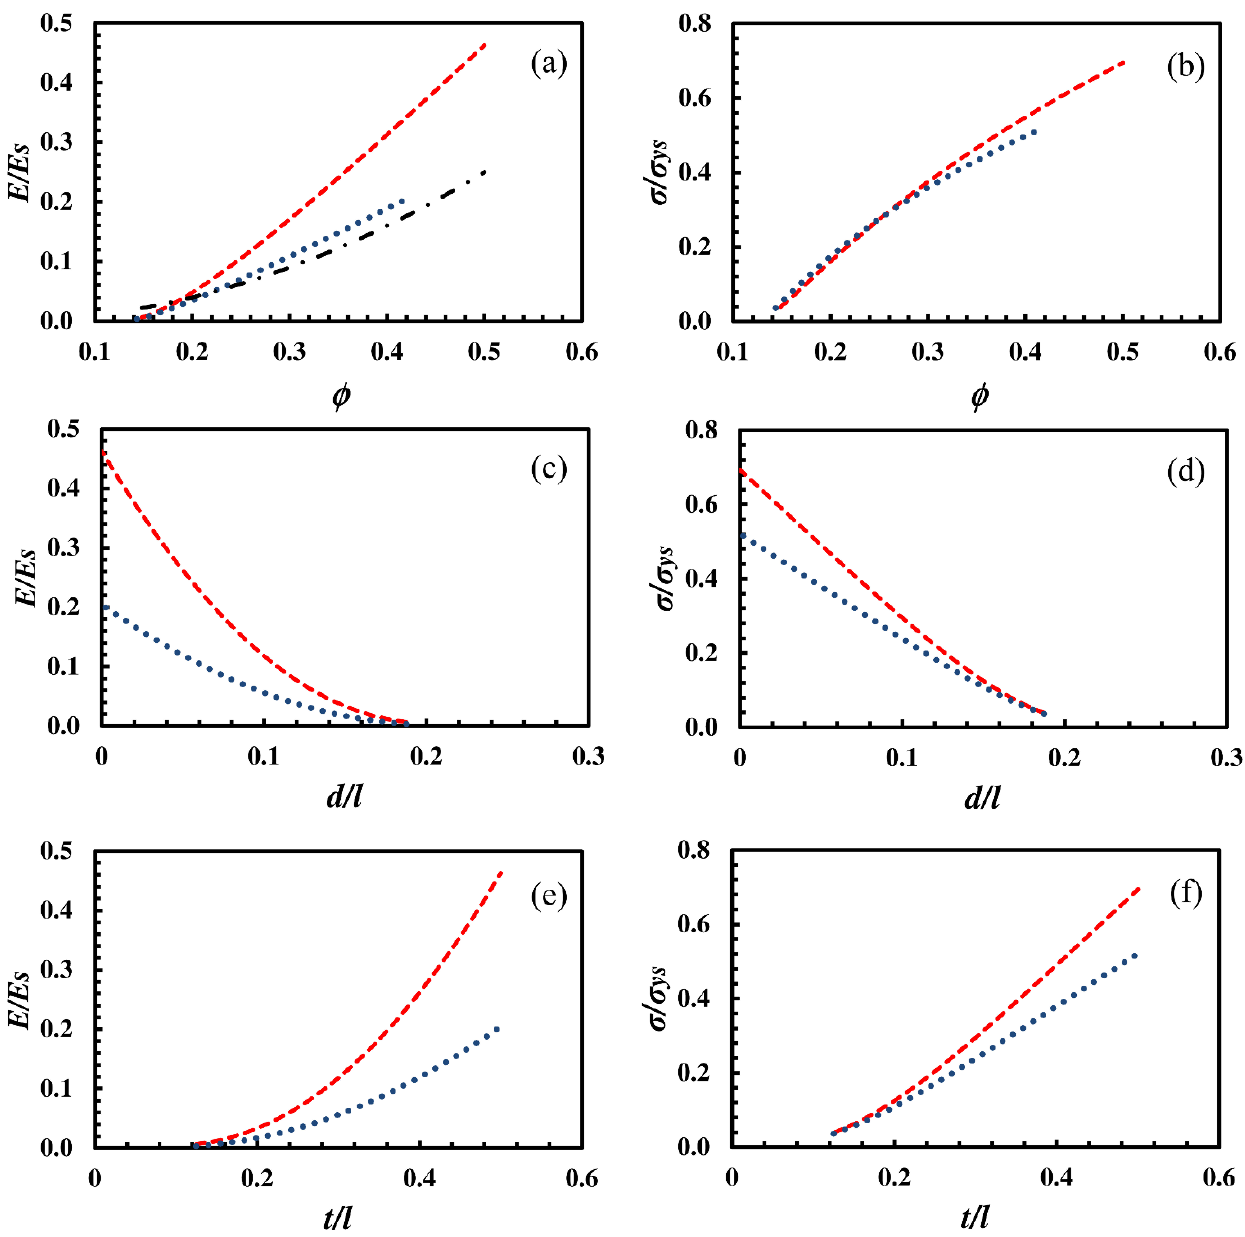
Figure 7. The relative Young’s modulus E / E s and the relative yield strength σ/σ ys as a function of relative density ϕ, respectively ( a ) and ( b ); of the ratio d / l , respectively ( c ) and ( d ); and of the ratio t / l , respectively ( e ) and ( f ). Results were obtained keeping h / l constant at the value of 0.5. Dashed ( ‒ ‒ ‒ ) and dotted (• • •) lines refer to the cases of ligaments with square and circular cross-sections, respectively. The dash dot line ( − · − · ) indicates the values obtained with Gibson and Ashby’s